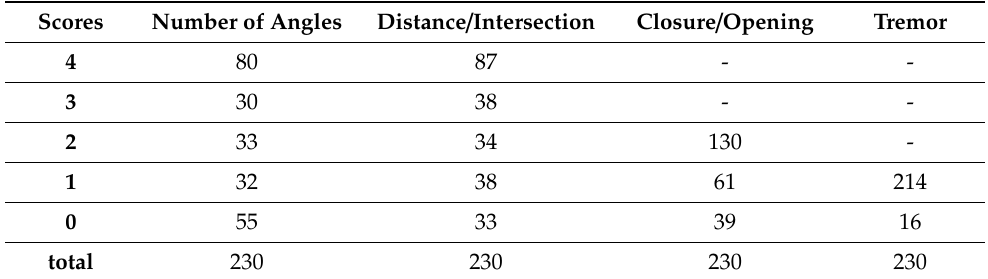
Table 4. Frequency of the ground truth of the 230 images by score in each parameter of the scoring method of the